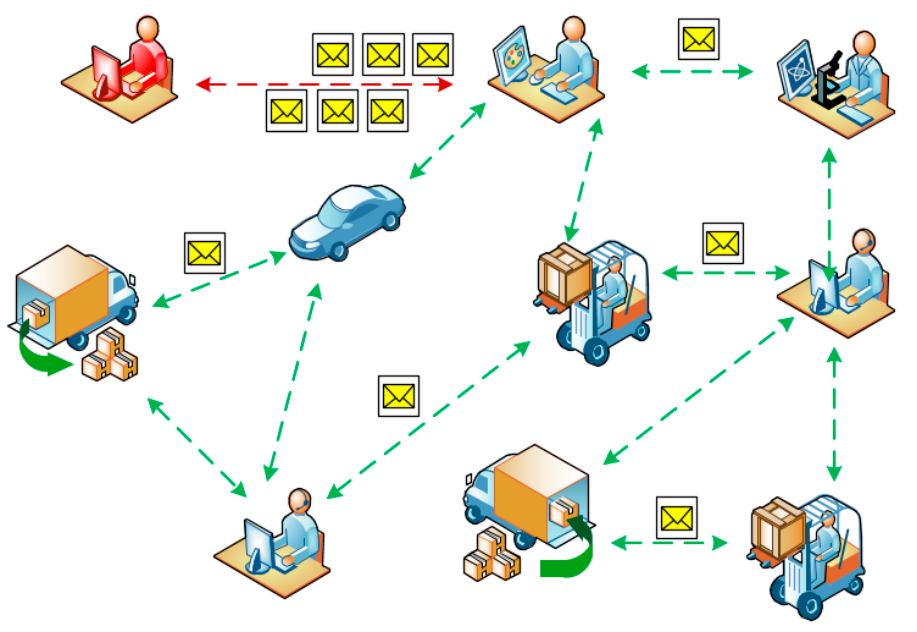
Figure 3. A denial of service ( DoS) attack case.